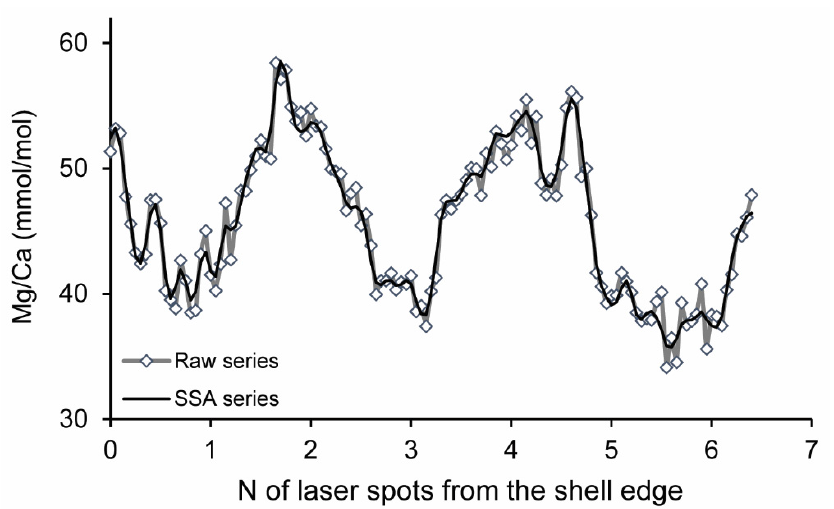
Figure 5. Mg/Ca ratios obtained with the proposed CF-LIBS procedure (grey line) and the same data postprocessed with the SSA algorithm (black line).